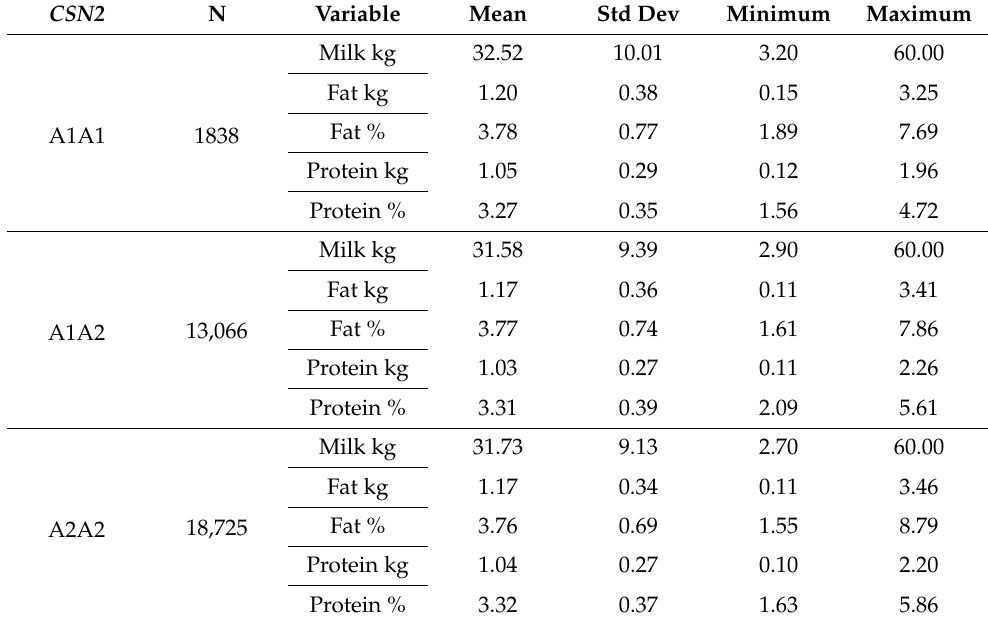
Table 8. Descriptive statistics for the milk variables by genotypes (test day records).